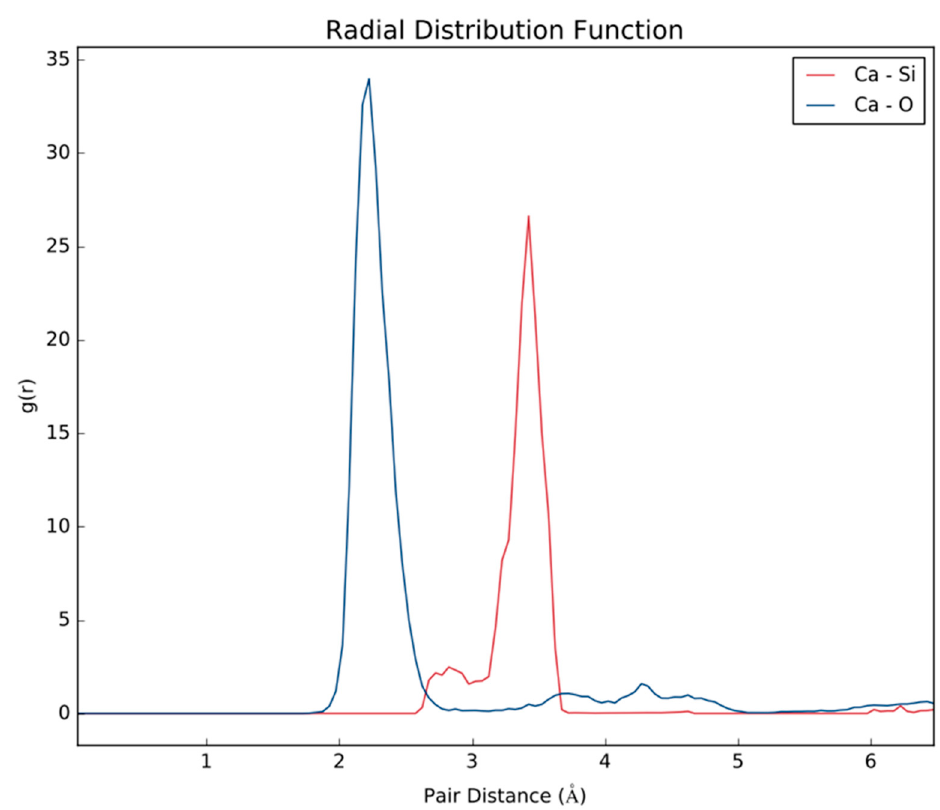
Figure 10. The radial distribution function (RDF) of the MD trajectory of PAM-Silica with Ca 2+ ions and water molecules.